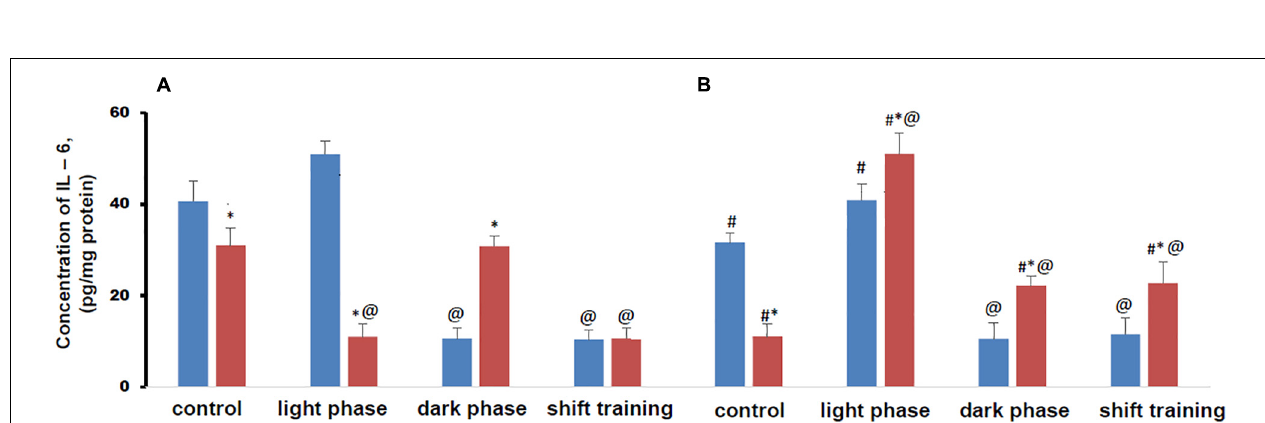
FIGURE 4 | Mice body mass on the 16-th week of the experiment (grams). Panel (A) shows young-age mice. Panel (B) shows old-age mice. Blue columns represent chow diet and red columns represent high fat diet. Data are presented as the mean ± error of the mean. *Significantly different ( p < 0.05) from Chow diet. #Significantly different ( p < 0.05) from young-age mice. @Significantly different ( p < 0.05) from control.